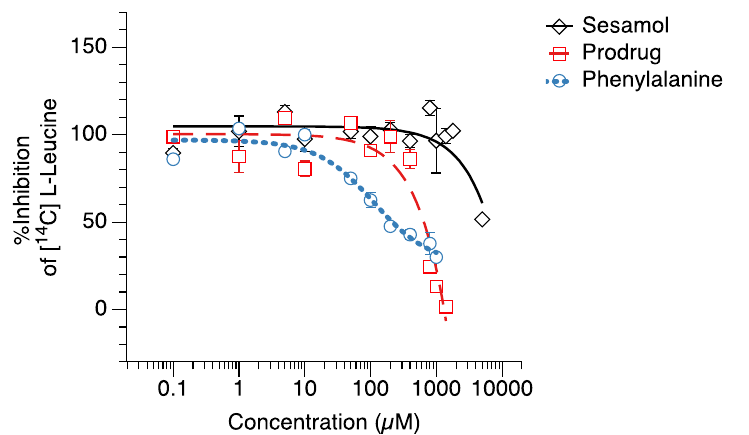
) sesamol prodrug, and ( ) (cid:51) (cid:35)